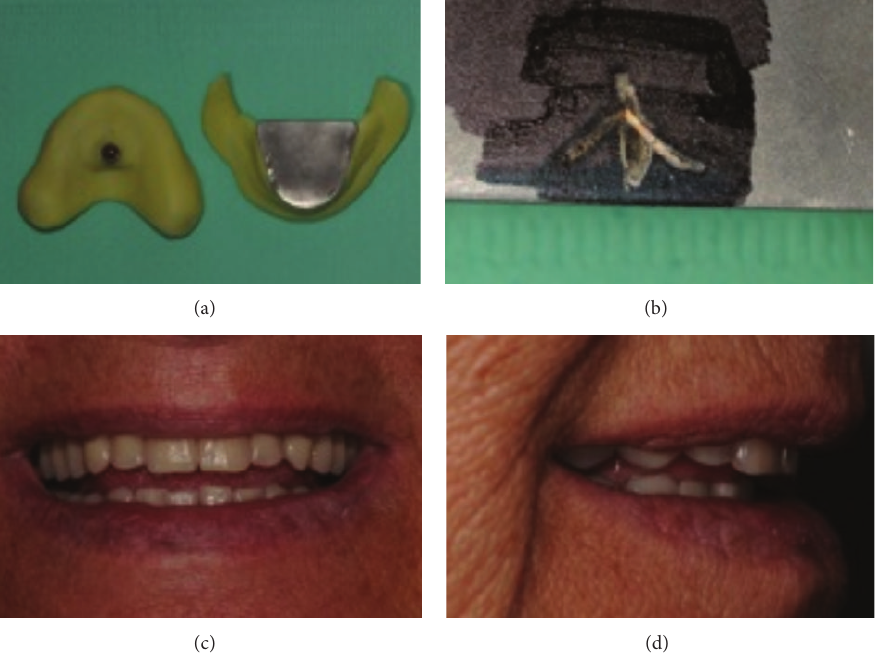
Figure 2: Registration of the gothic arch, according to central bearing point (CBP), to restore the correct interarch relationships ((a), (b)), the new dentures in use ((c), (d)).